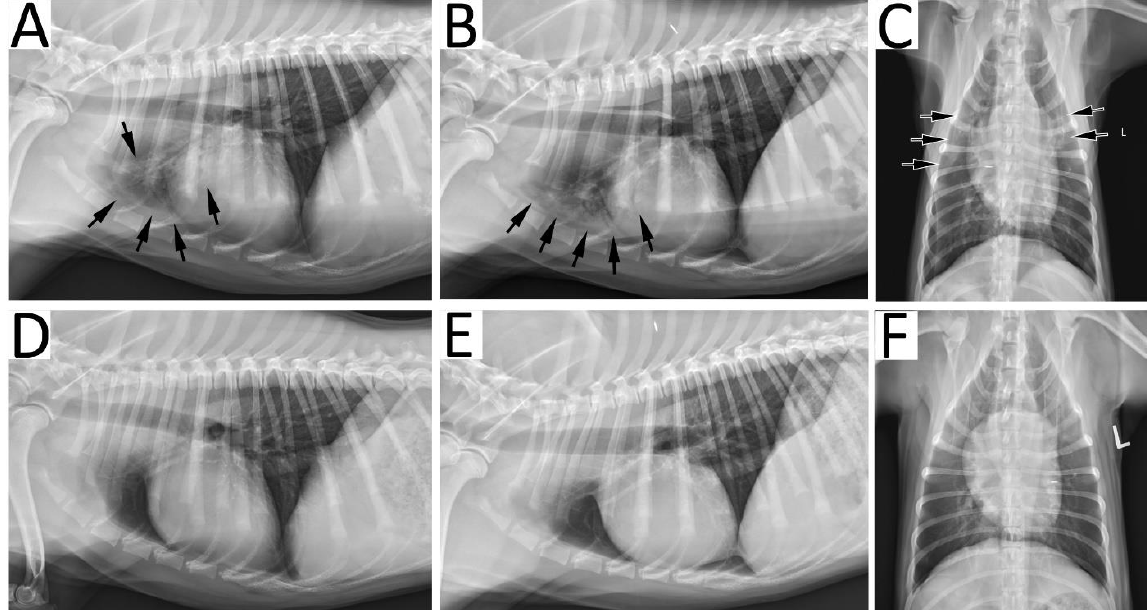
Figure 2. Radiographic resolution of bacterial pneumonia in a 9-month-old male neutered Golden Retriever dog. At initial presentation, right lateral ( A ), left lateral ( B ) and ventrodorsal ( C ) recumbent radiographic projections demonstrated an alveolar pattern (arrows) in the cranial lung fields characterized by increased opacification, air bronchograms and indistinct pulmonary vasculature. Since both the cranial segment of the left cranial lung lobe and right cranial lung lobe were affected, a global radiographic score of 4 was assigned, corresponding to multifocal consolidation. After a full course of therapy, right lateral ( D ), left lateral ( E ) and ventrodorsal ( F ) recumbent projections show resolution of lung lesions and thus, a global radiographic score of 1 was given.